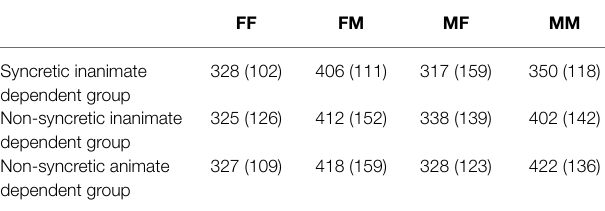
TABLE 2 | Experiment 1: mean RTs (in ms) and standard deviations (in parentheses) in region 5 in different experimental conditions. FF FM MF